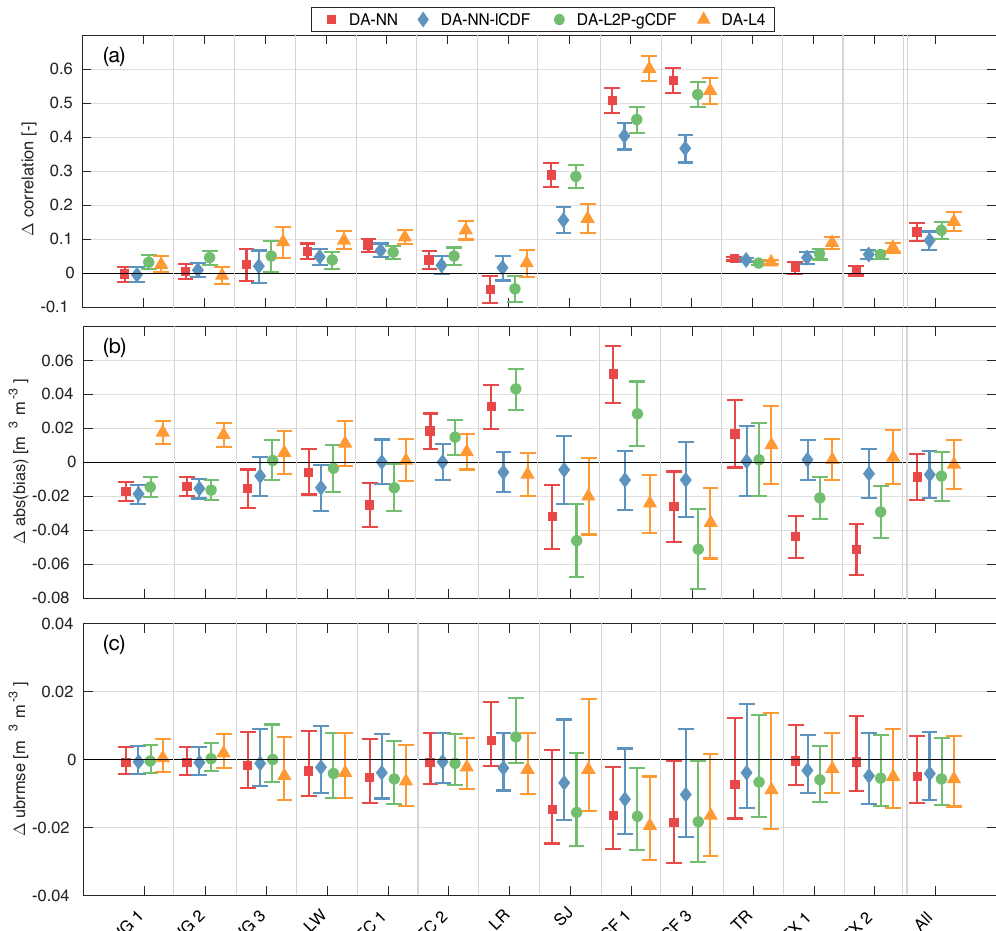
Figure 2. Change in surface soil moisture: ( a ) correlation, ( b ) absolute bias, and ( c ) unbiased root-mean-square error (ubRMSE) versus core validation site (CVS) measurements for the DA-NN (red squares), DA-NN-lCDF (blue diamonds), DA-L2P-gCDF (green circles) experiments and the DA-L4 (orange triangles). Skill changes have been computed against the OL corresponding to each experiment as DA minus OL. Error bars denote the 95% confidence interval. Reference pixel abbreviations are listed in Table